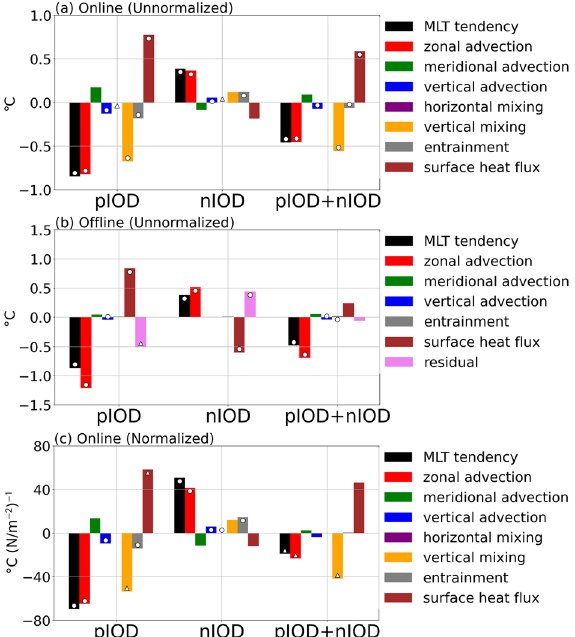
Figure 2. Mixed layer heat budget of pIOD and nIOD years. ( a ) Mixed layer temperature (MLT) tendency (black), zonal advection (red), meridional advection (green), vertical advection (blue), horizontal mixing (purple), vertical mixing (orange), entrainment (grey), and surface heat flux (brown) term anomalies (in °C) integrated over the development phase from April (0) to September (0) for the pIOD (left) and the nIOD (middle). Their sums are also presented (right). The circles (triangles) indicate that anomalies are significant at the 95% (90%) confidence level by a two-tailed t test. ( b ) As in ( a ), but with an offline calculation. The residual term is indicated by a violet bar. ( c ) As in ( a ), but normalized by the atmospheric forcing (i.e., EQUINOO, see